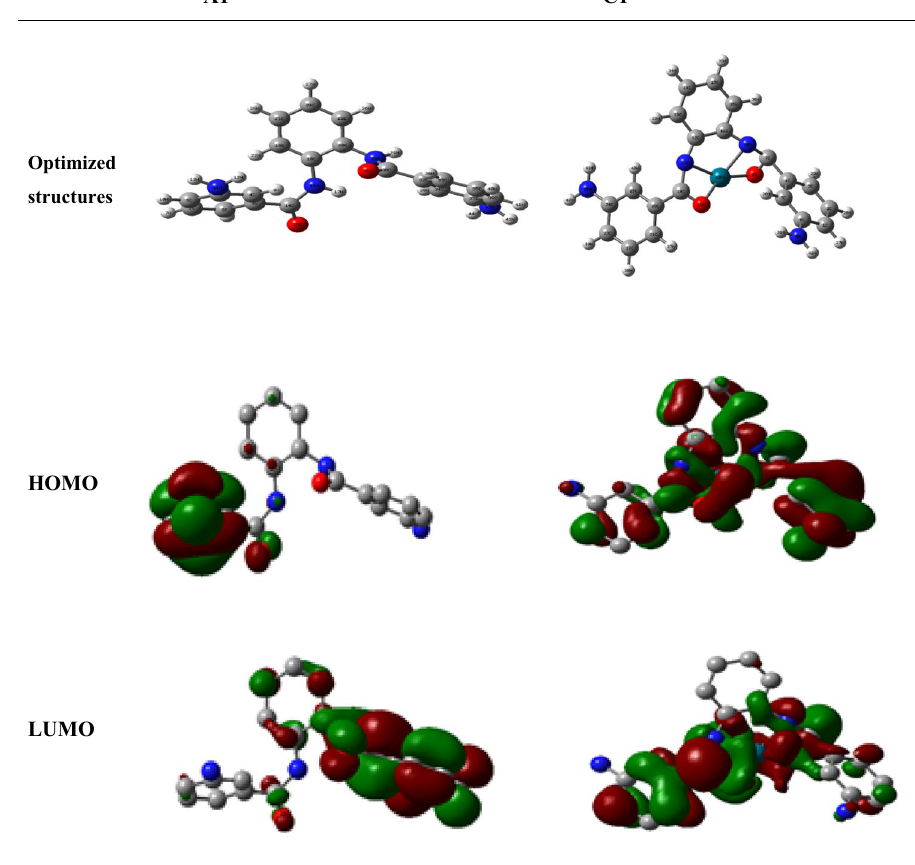
Figure 5. Optimized structures, HOMO and LUMO based on DFT calculations by using B3LYP method with 6–31 g ( d ) basis sets.